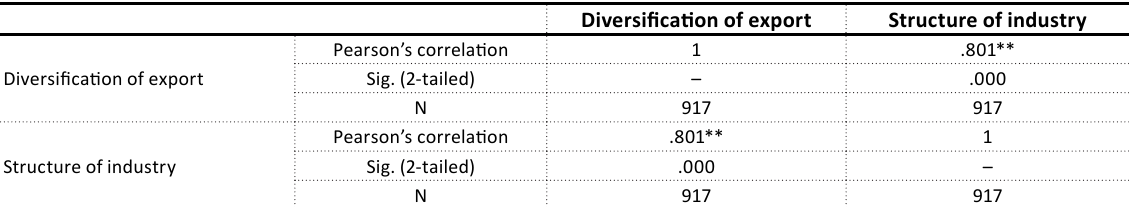
Source: Author analysis, output from SPSS